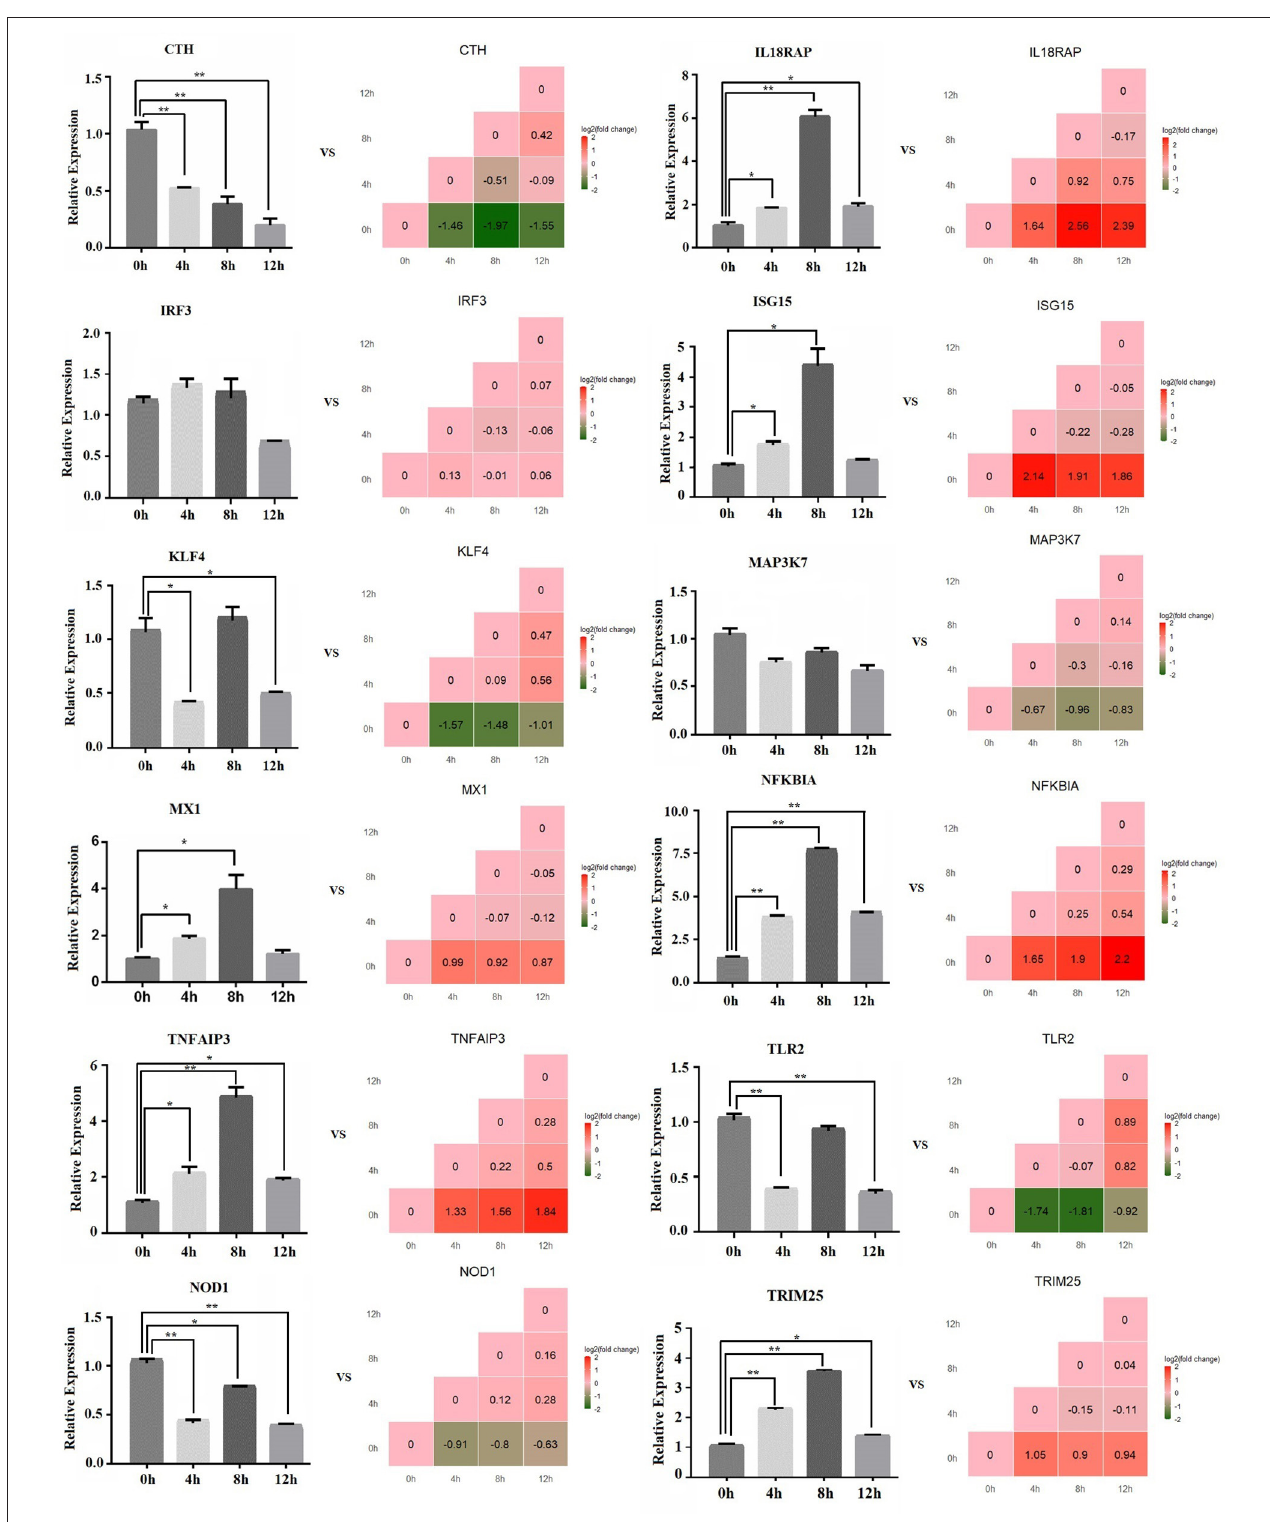
FIGURE 3 | The relative expression level of mRNA by qPCR. The bar graph shows the qPCR result, and the stair graph shows the sequencing result; 0, 4, 8, and 12h represent the LPS-induced 0, 4, 8, and 12h bMECs; “*” represents P ≤ 0.05; “**” represents P ≤ 0.01.